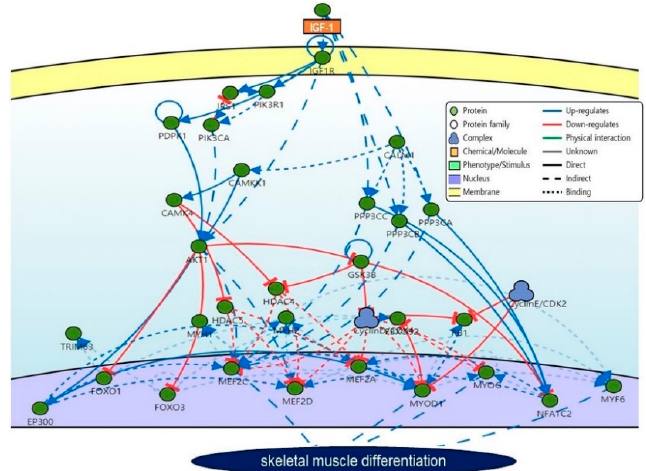
Figure 3. Protein-Protein interactions of IGF-1 with its associated proteins generated by ( A ) SIGnaling Network Open Resource, ( B ) STRING.